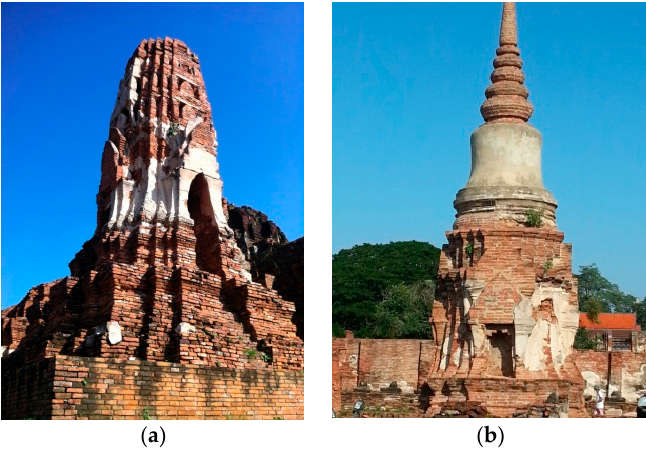
Figure 2. Pagodas at Wat Maha That. ( a ) Prang structure. ( b ) Chedi structure.